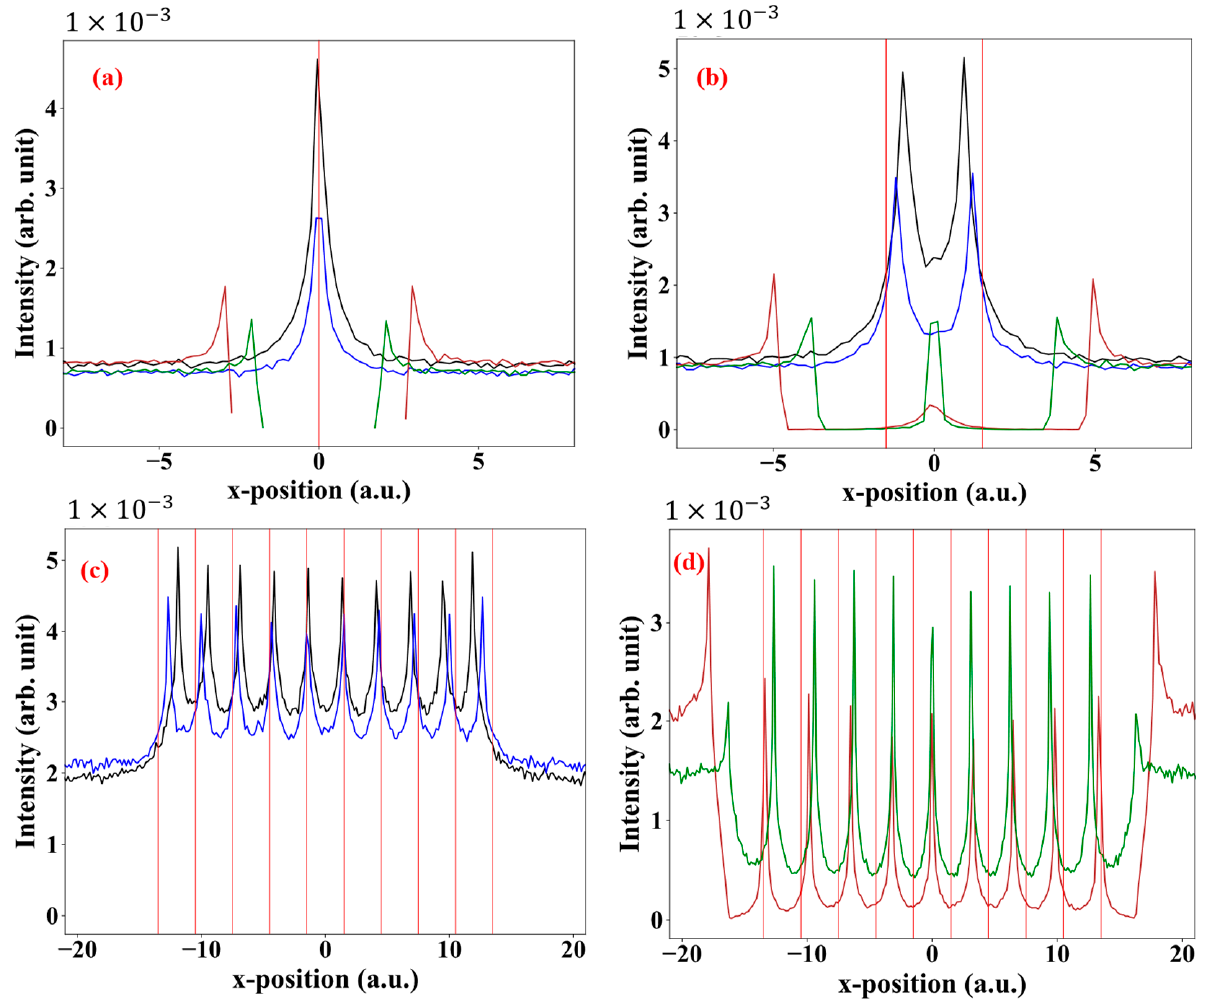
Figure 3. Intensity distribution of projectiles at the detection plane: ( a ) one-proton system, ( b ) two- proton system, ( c ) ten-proton system with electrons, ( d ) ten-proton system with positrons. Vertical red line indicates the x-position of protons. Black solid line: 500 eV electrons, blue solid line: 1000 eV electrons, brown solid line: 500 eV positrons and green solid line: 1000 eV positrons.